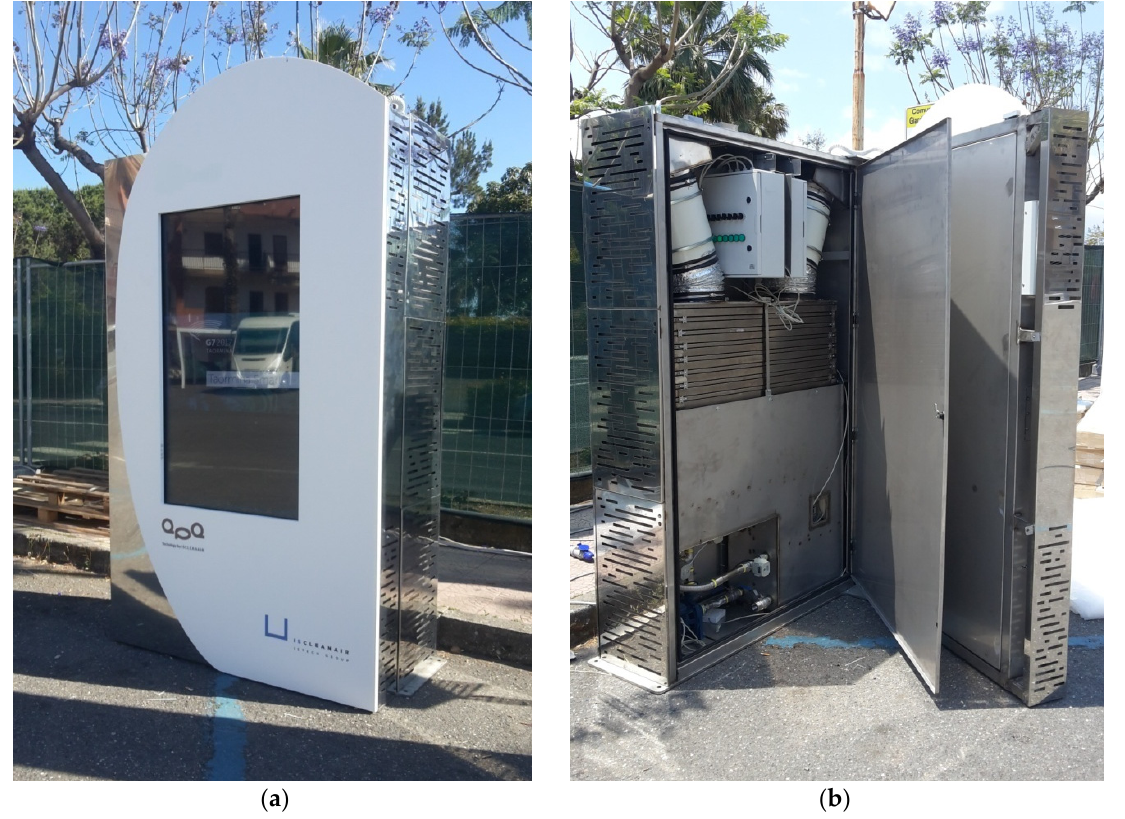
Figure 2. APA Totem (1300 × 400 × 2100 mm, AISI (American Iron and Steel Institute) 304 stainless steel). The multimedial 55-inch touch-screen is installed in the central part of the front panel ( a ). Internal view of the system ( b ).